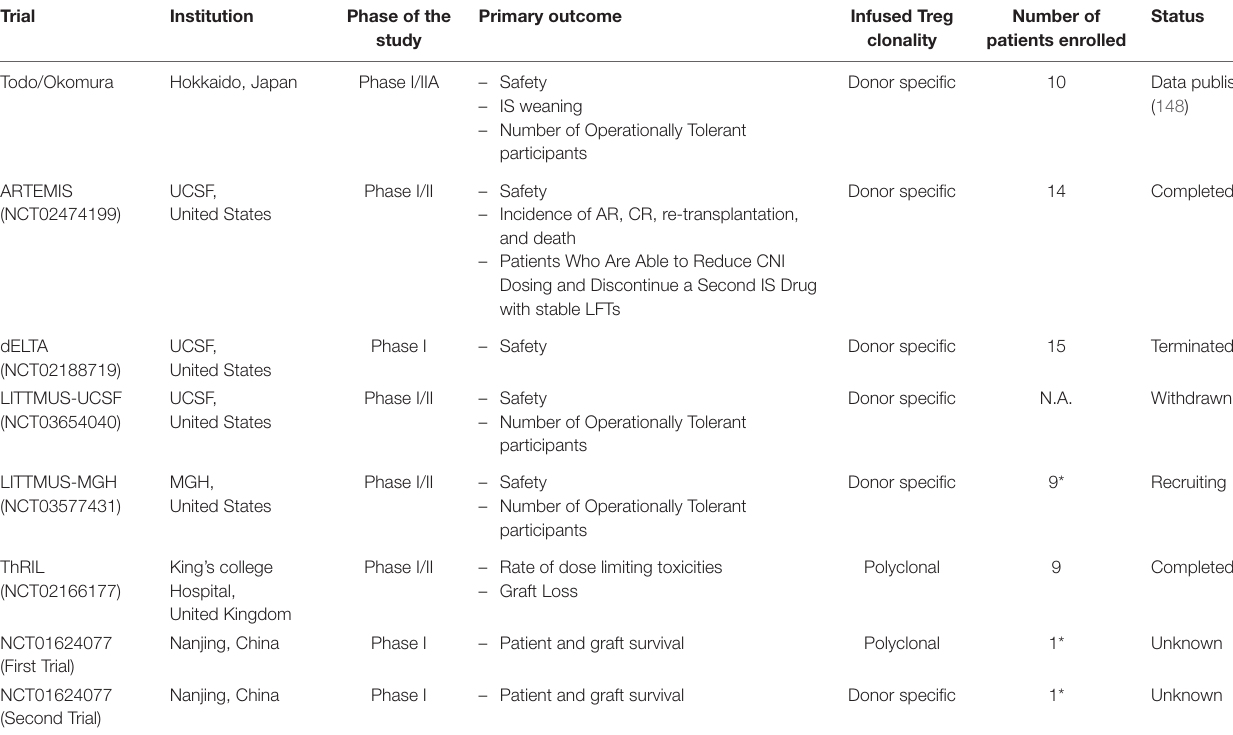
TABLE 1 | Registered clinical trials involving regulatory T-cell therapy in liver